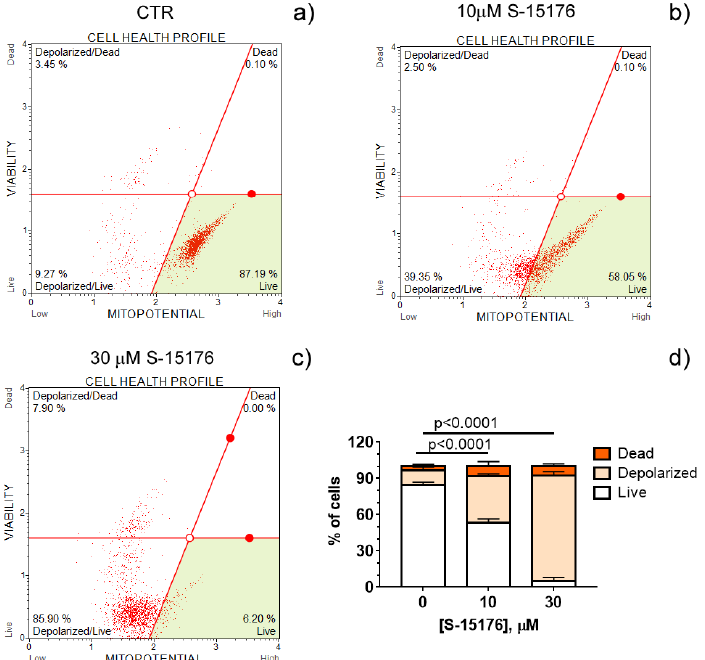
Figure 1. S-15176 difumarate salt induces the depolarization of the mitochondrial membrane in rat thymocytes. Mitochondrial membrane potential (MitoPotential) was assessed with the Muse Cell Analyzer using the Muse MitoPotential kit. Cells were treated with 0 μM S -15176 ( a ), 10 μM S-15176 ( b ), or 30 μM S -15176 ( c ) for 30 min. Typical profile plots are presented. Panel ( d ) shows the ratio (%) of living, depolarized, and dead rat thymocytes in the presence of S-15176 at different concentrations. In control experiments (CTR, 0 µM S-15176), an equivalent volume of the solvent (0.1% DMSO) was used. Data represent the mean ± SEM ( n = 4).